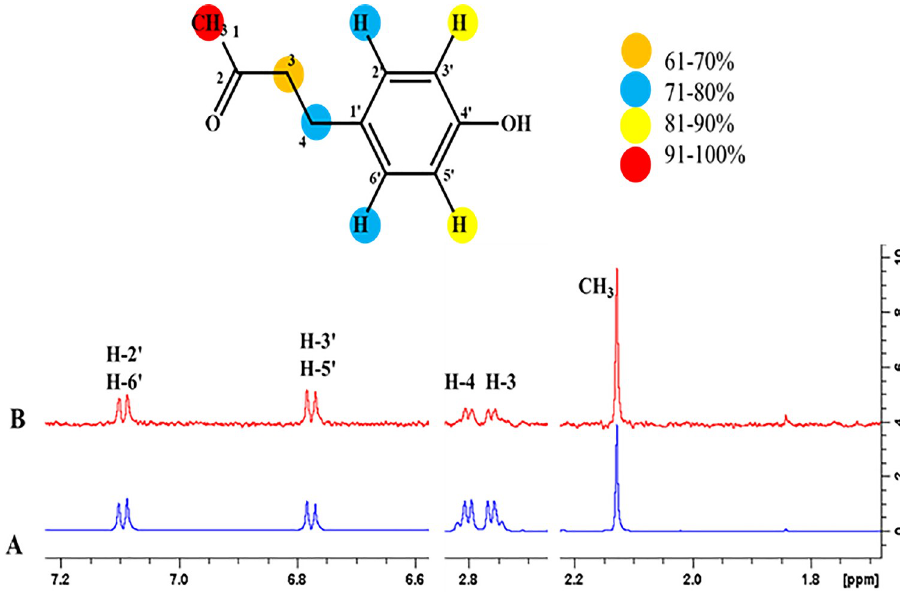
Fig 23. (A) Reference 1 H-NMR spectrum of ligand 28 . (B) Difference spectrum of ligand 28 with the enzyme.